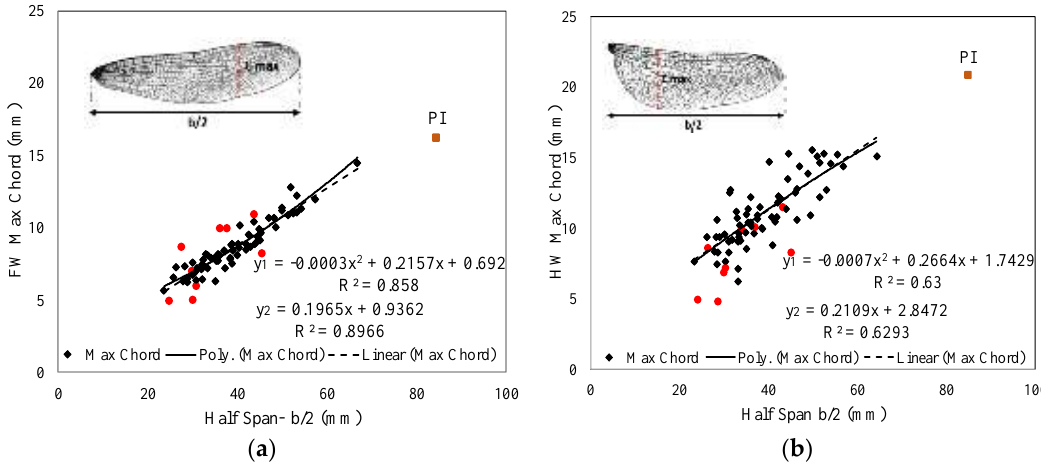
Figure 10. Maximum chord versus wing semi-span of the forewings ( a ) of dragonflies, and maximum chord versus wing semi-span of the hindwings ( b ) of dragonflies.